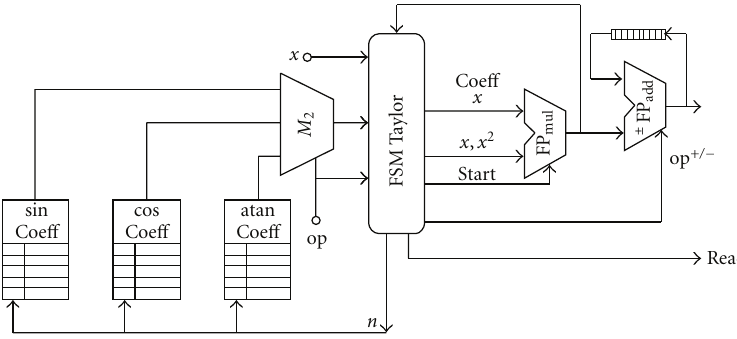
Figure 4: IEEE-754